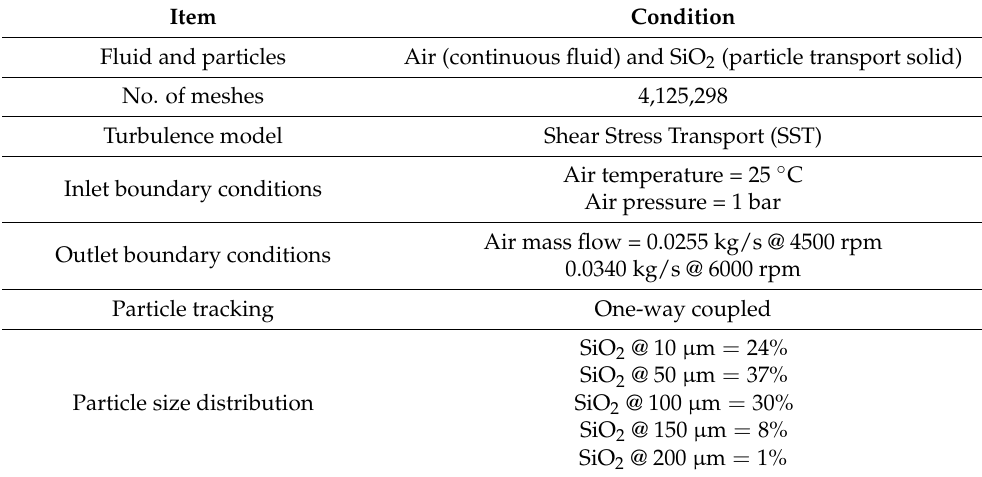
Table 3. Computational fluid dynamics (CFD) model and boundary